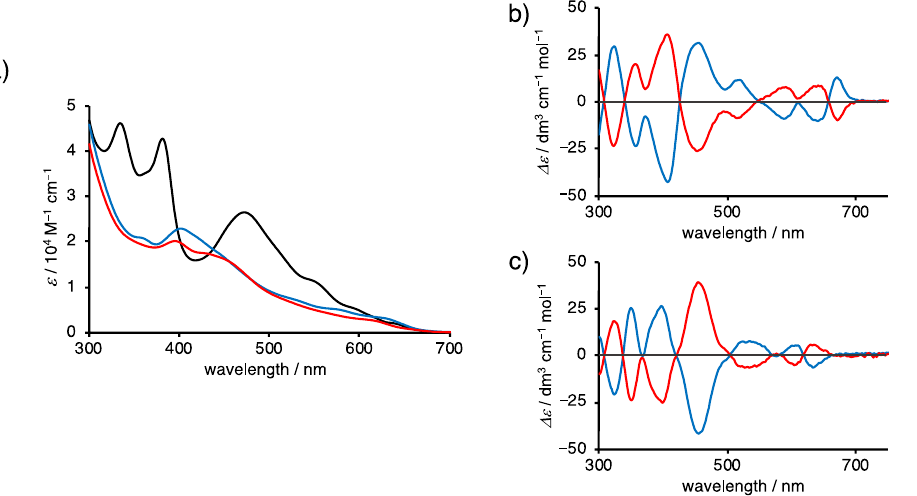
Figure 5. UV–visible absorption and CD spectra. ( a ) UV–vis absorption spectra of X70A (blue line), X70F (red line), and for comparison, C 70 (black line) in toluene. ( b ) Blue and red lines represent the CD spectra in toluene for the first ( X70A1 : 9.6 × 10 −6 M) and second ( X70A2 : 5.1 × 10 −6 M) fractions, respectively. ( c ) Blue and red lines represent the CD spectra in toluene of the first ( X70F1 : 6.1 × 10 −6 M) and second ( X70F2 : 5.1 × 10 −6 M) fractions,